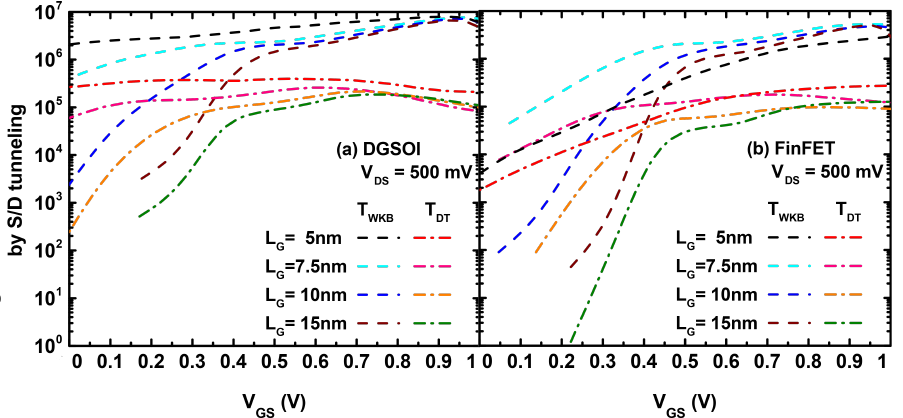
Figure 5. Average number of electrons (in arbitrary units) affected by S/D tunneling as a function of the V GS in the ( a ) DGSOI and ( b ) FinFET devices at V DS = 500 mV with L G = 5, 7.5, 10, and 15 nm,